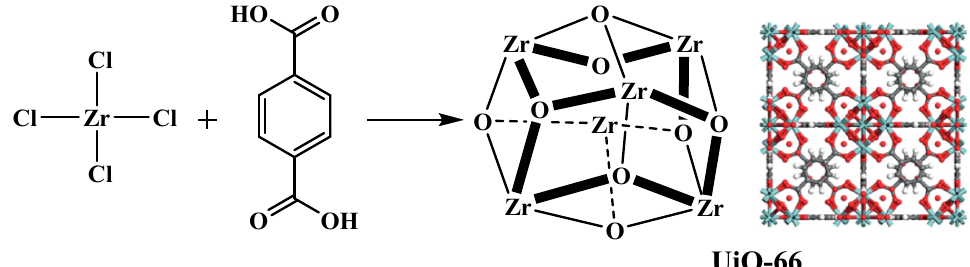
Figure 2. Schematic diagram of the structure and synthesis of